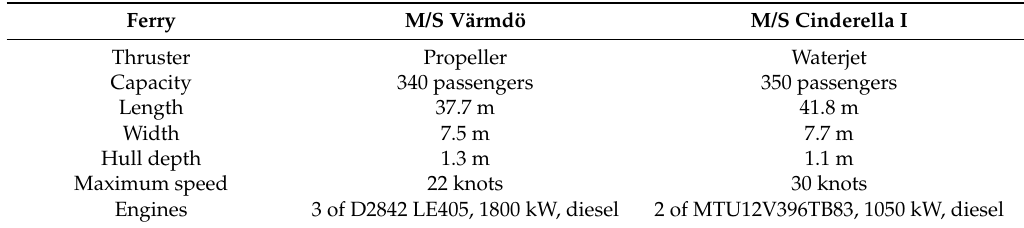
Table 1 . Technical specifications of the observed ferry boats. 1 Table 1. Technical specifications of the observed ferry boats.